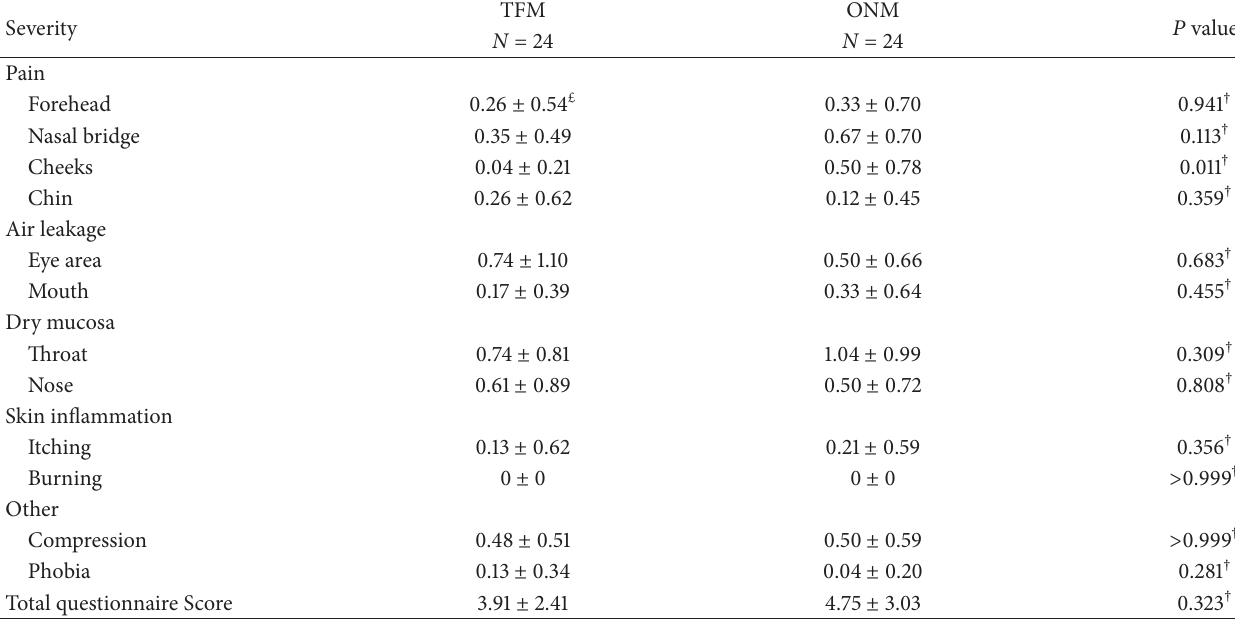
Table 4: Comfort of the masks based on the items evaluated in the